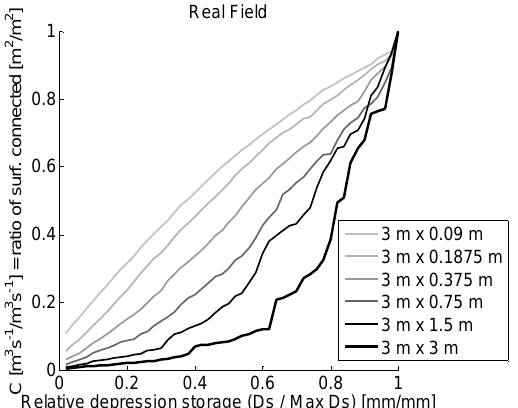
Figure 7: Real Field - Effect of plot length on the normalized RSC function. Depression 2 Fig. 7. Real field – effect of plot length on the normalized RSC function. Depression storage (x-axis) was scaled by the maximum storage (x axis) was scaled by the maximum depression storage. The numbers in parentheses 3 depression storage. The numbers in parentheses indicate the number indicate the number of connectivity curves used for calculating the average normalized RSC 4 of connectivity curves used for calculating the average normalized functions. All the plots are 3 m wide. 5 RSC functions. All the plots are 3m wide.